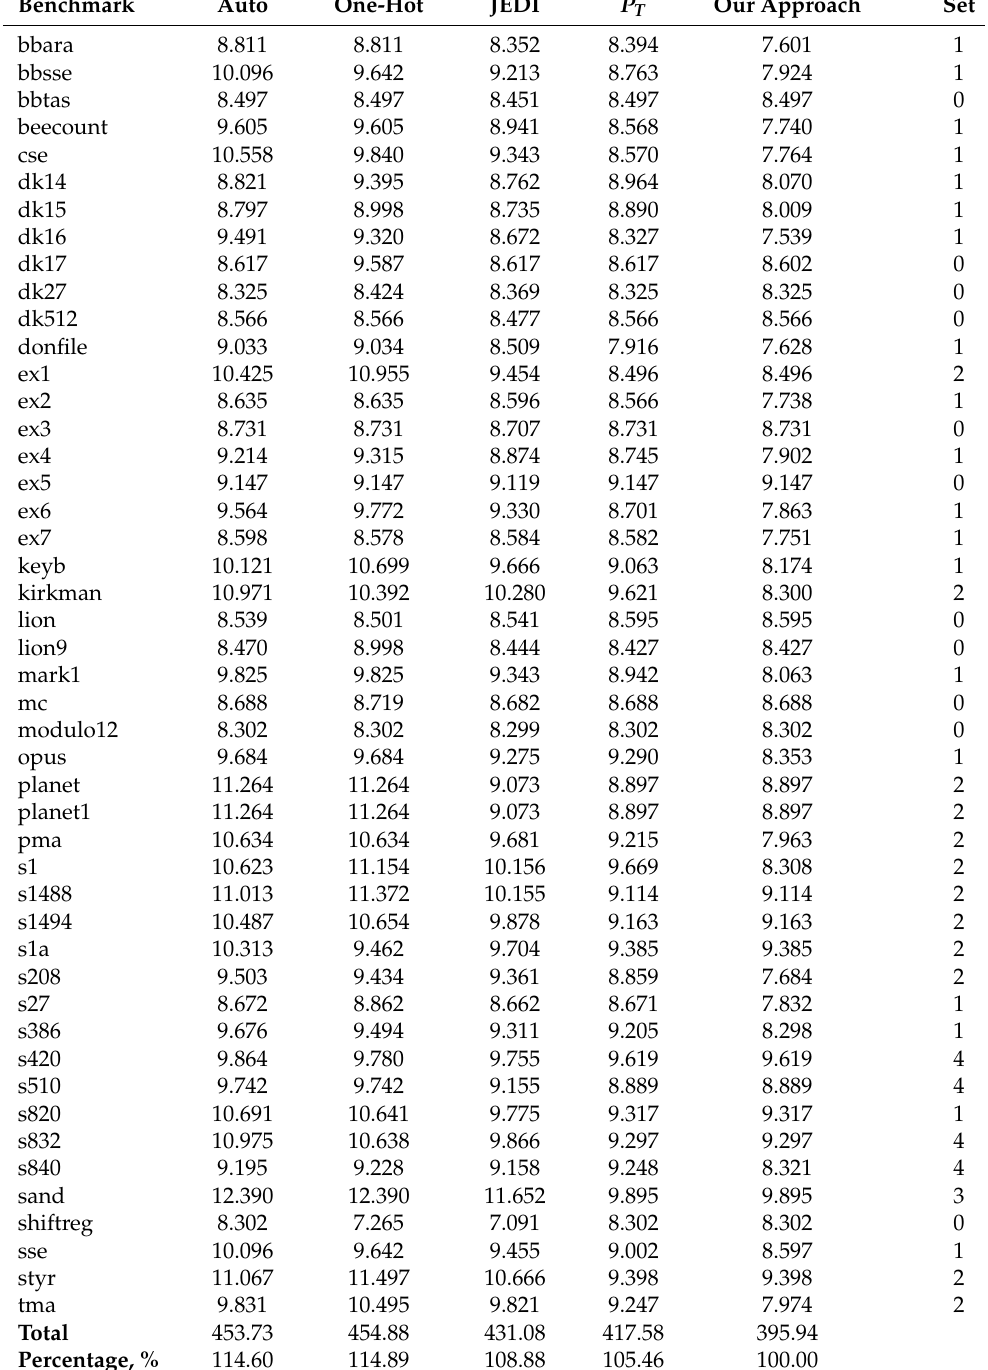
Table 10. Experimental results (the minimum cycle time,